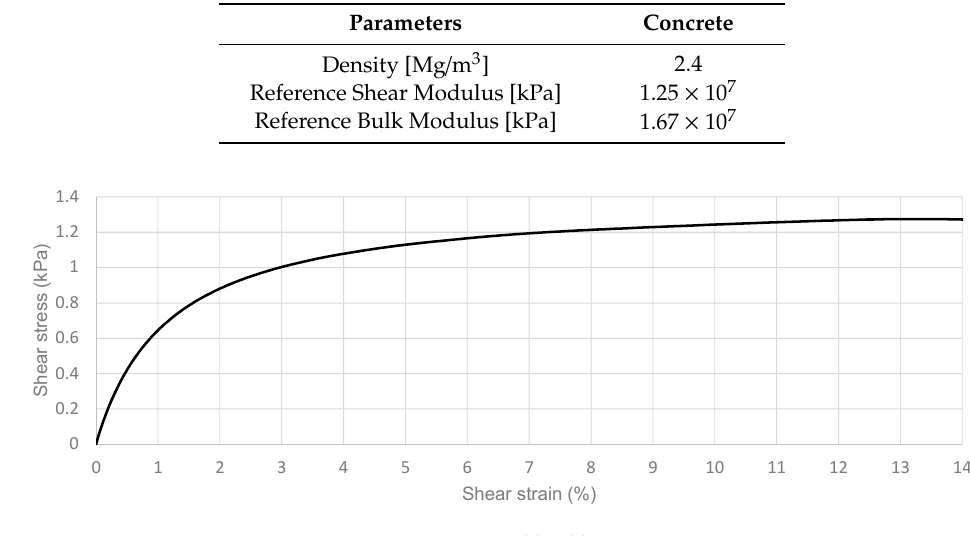
Figure 4. GSI material backbone curve. Table 5. GSI liner and soil parameters.